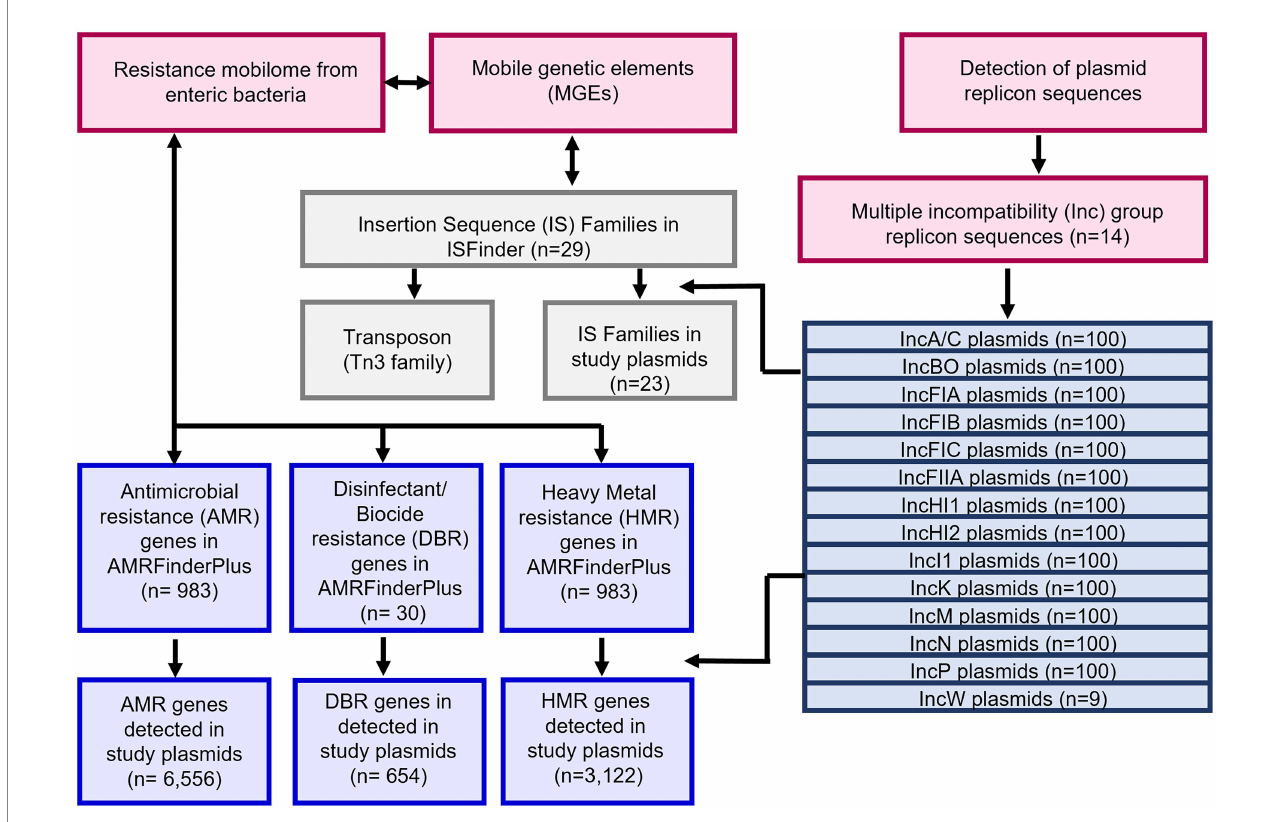
FIGURE 1 Workflow of the study to examine the resistance gene and MGE content of multiple plasmids representing those plasmid types most commonly associated with carrying antimicrobial resistance (AMR) genes in enteric bacterial